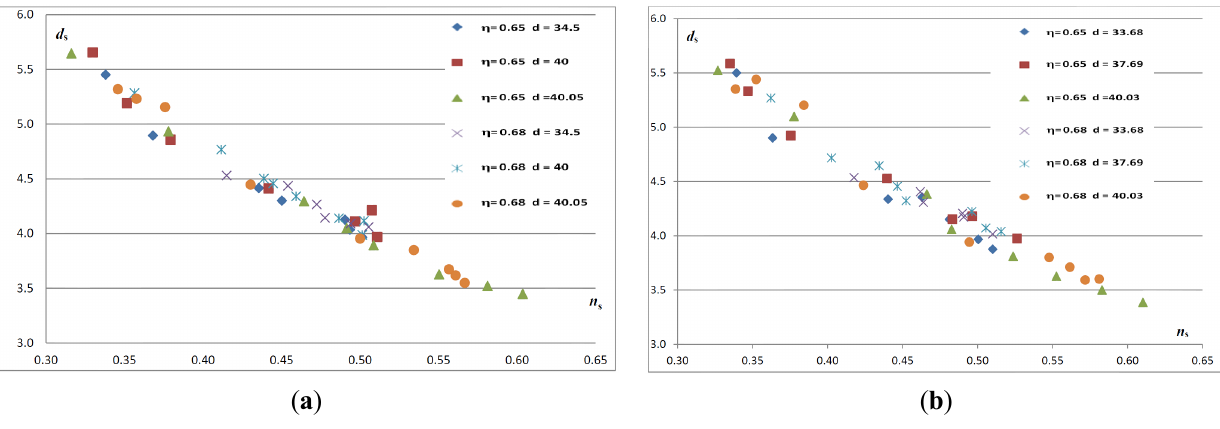
Figure 9. Iso-efficiency points (Cordier line) for different compressor impeller diameter: ( a ) Mitsubishi; and ( b )